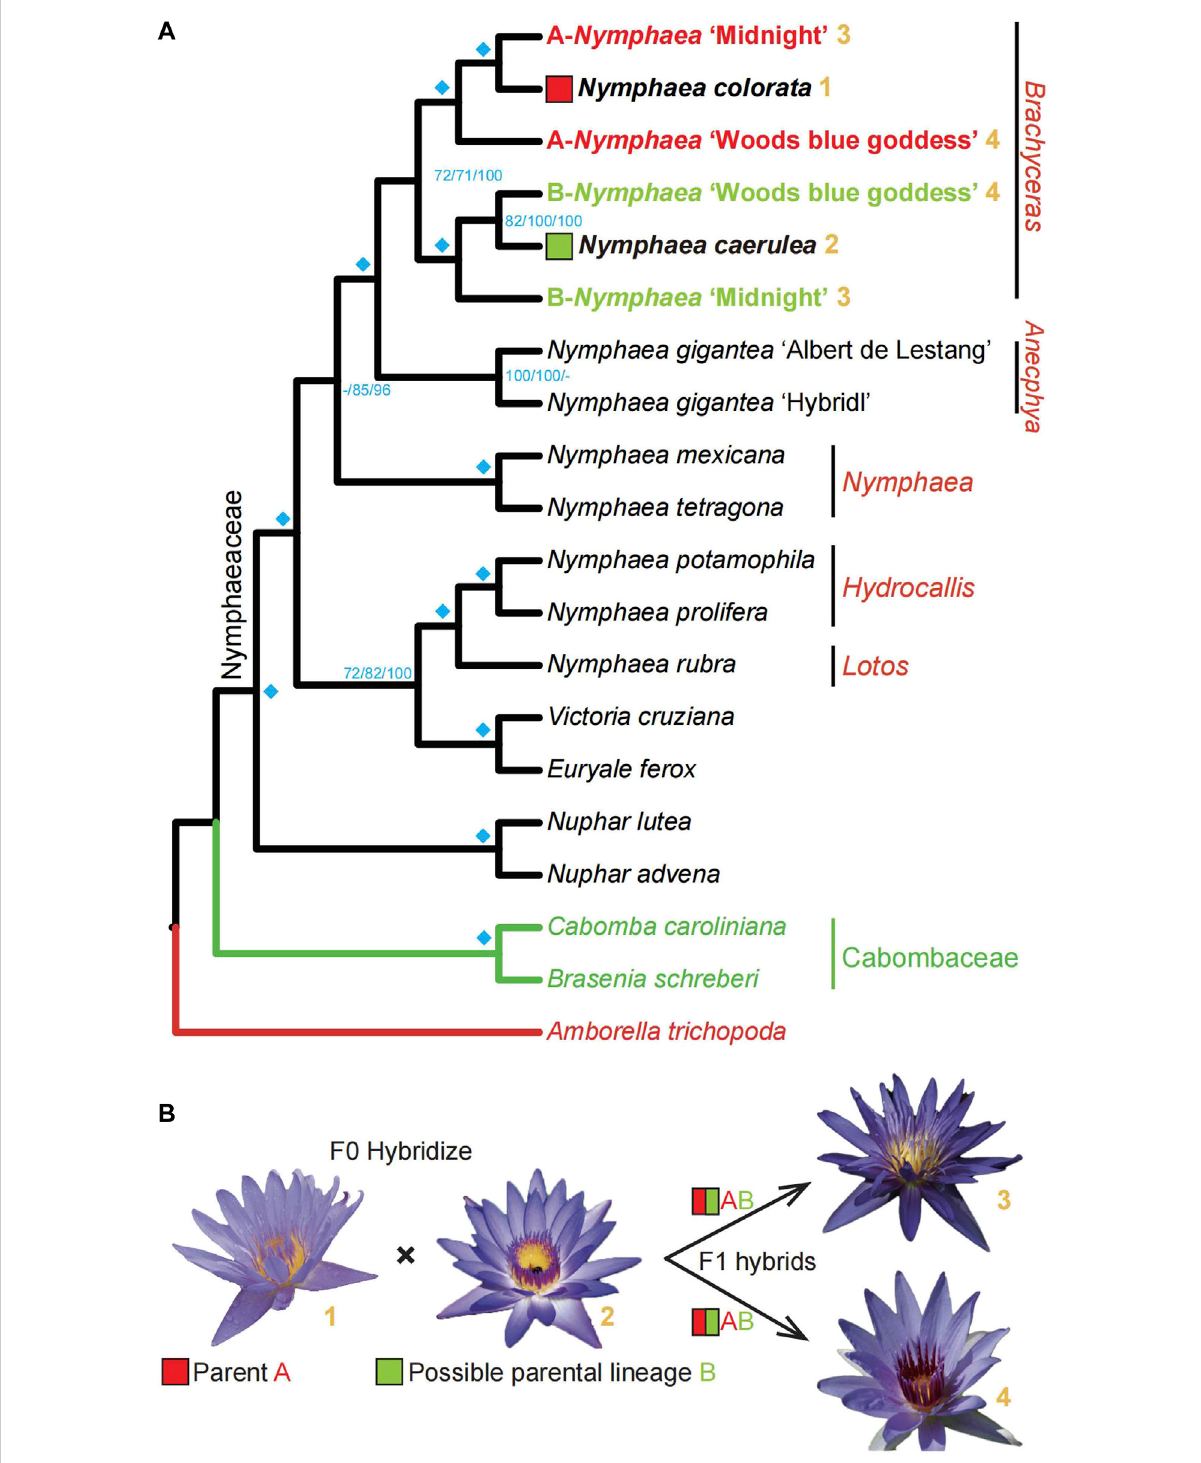
FIGURE 6 High-quality Nymphaeacolorata genomeandothertranscriptomesfacilitateasurveyofthehybridizationhistoriesof Nymphaea ’ Midnight ’ and Nymphaea ’ Woodsbluegoddess ’ . (A) .Thesummarizedphylogenyfromthreemulti-labeledphylogenetictreeswithcorrespondingbootstrapvalues on the nodes. In that order, the three supports value on this summarized tree nodes come from two coalescent trees of 125 and 248 genes and one supermatrix maximum-likelihood tree of 125 genes. The cyan diamonds on theleft of nodes indicate that all three bootstrap value are maximal